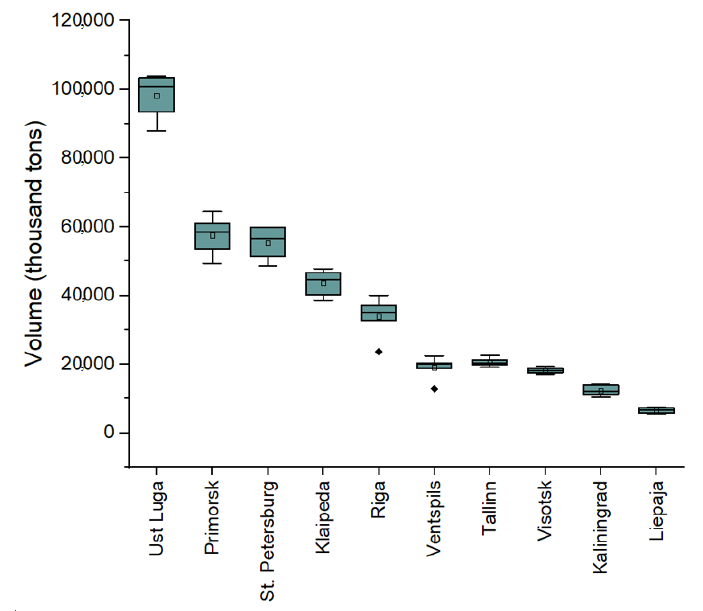
Figure 22. Distribution of cargo flows in ports of the eastern Baltic coast in 2015 – 2020.